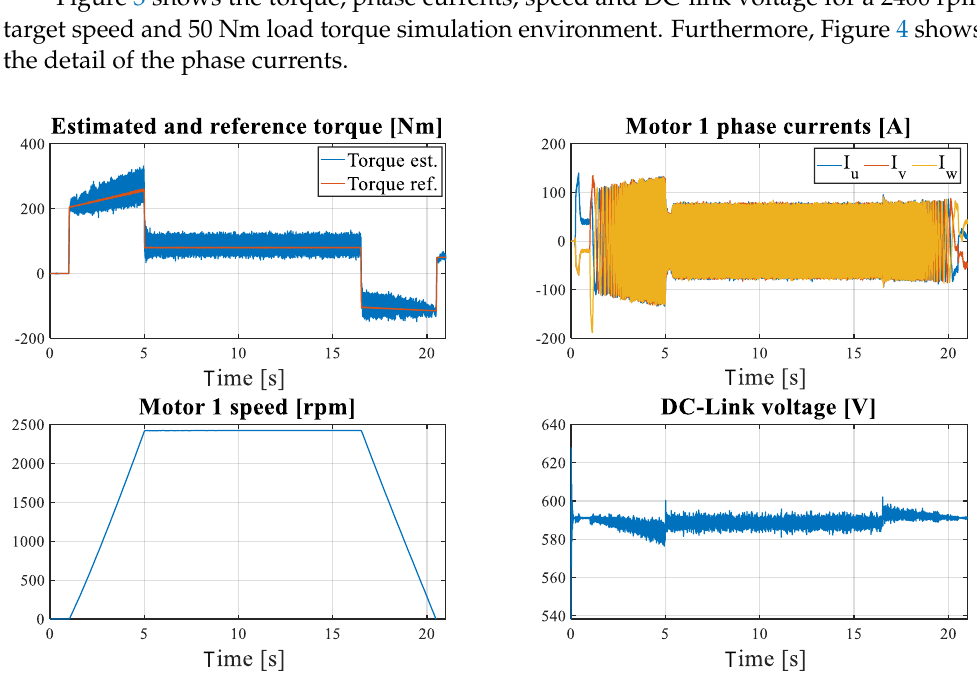
Figure 3. Torque, speed, phase currents and DC-link voltage signals at 2400 rpm and 50 Nm load (healthy state).